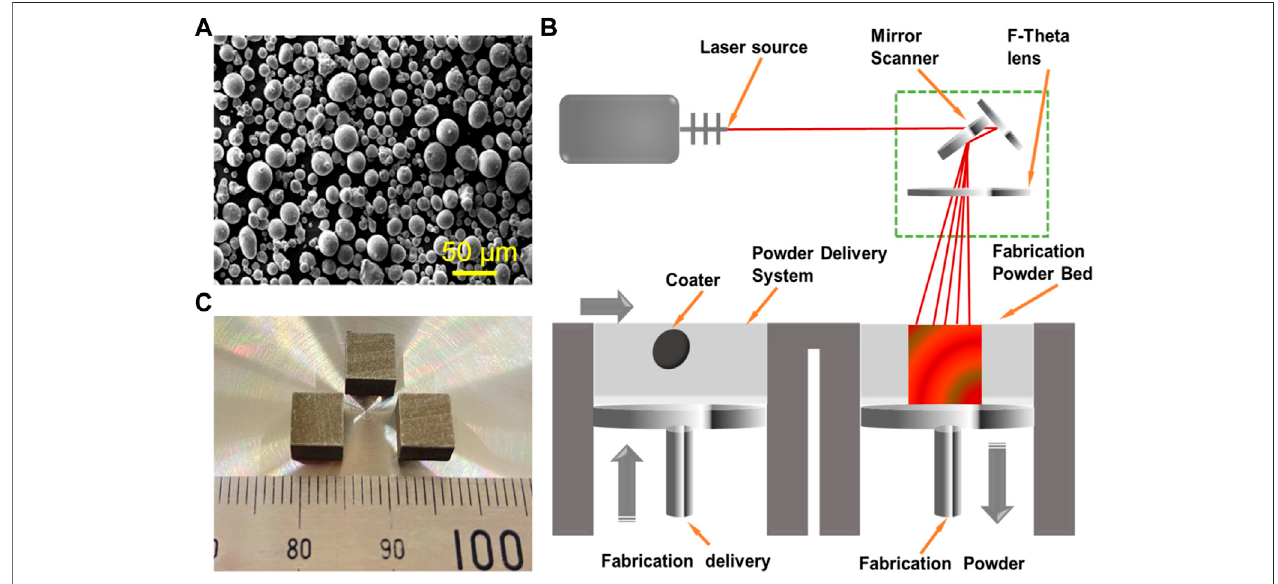
FIGURE 1 | (A) Sphere Fe powders. (B) Schematic diagram of laser additive manufacturing. (C) The as-built parts prepared by